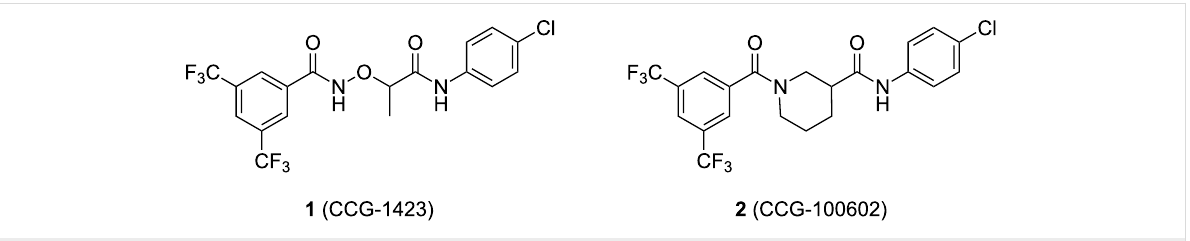
Figure 1: Structures of lead Rho/MKL1/SRF inhibitor 1 and conformationally restricted analogue 2 .